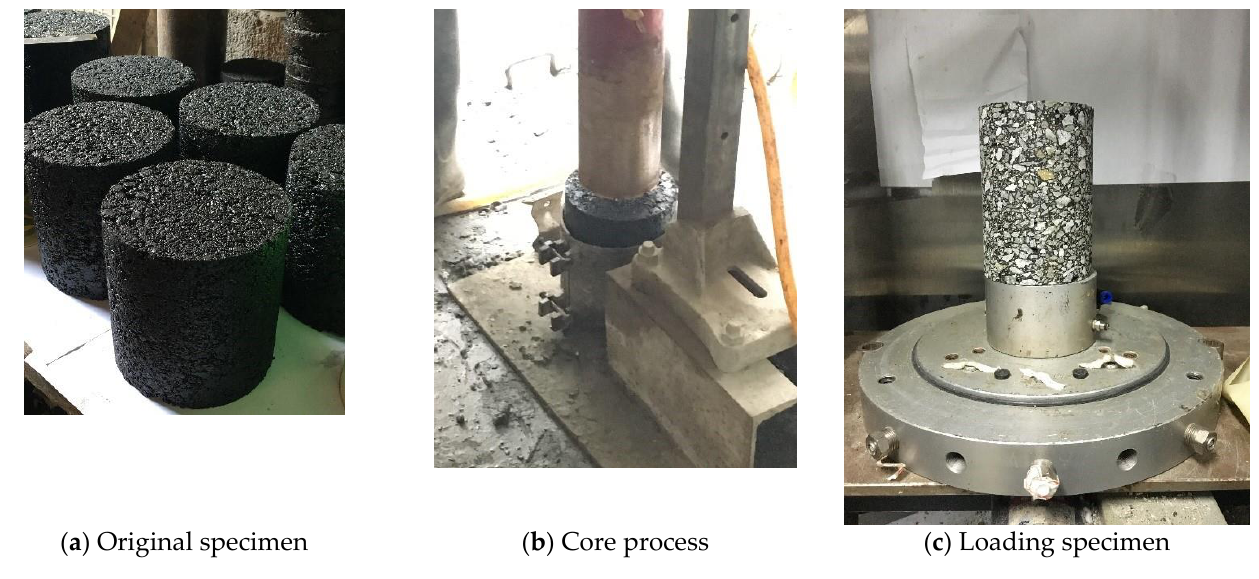
Figure 2. Process of specimen forming. ( a ) original specimen, ( b ) Core process, ( c ) Loading specimen.